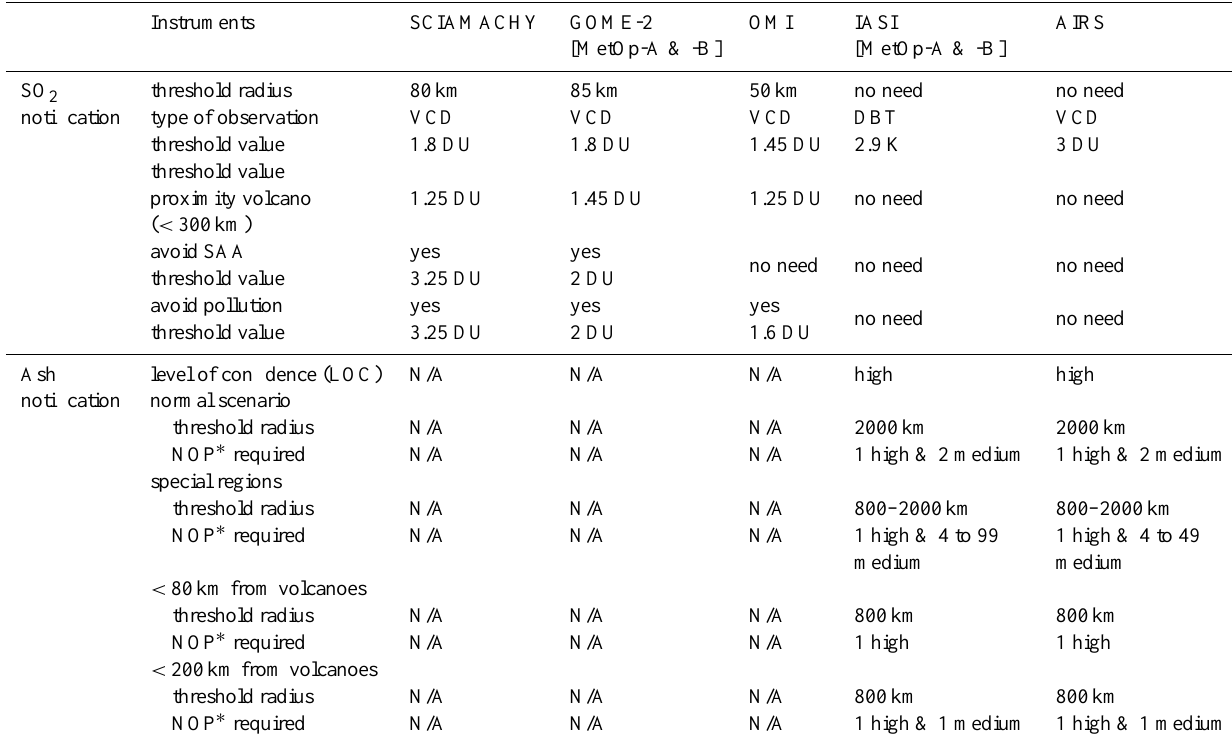
Table 3. Key criteria used by the SACS notification system. Instruments